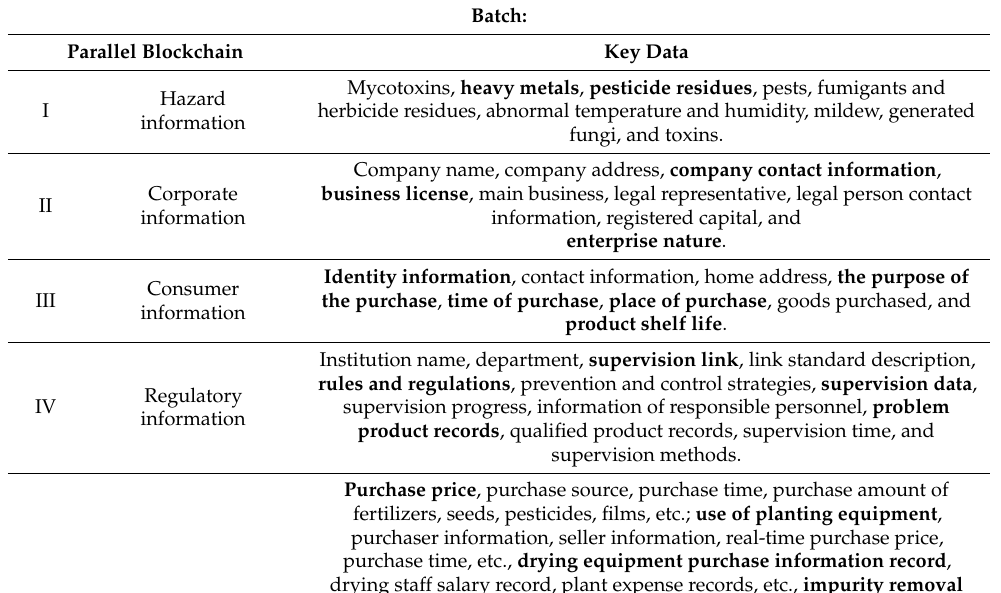
Table 2. Parallel blockchain data